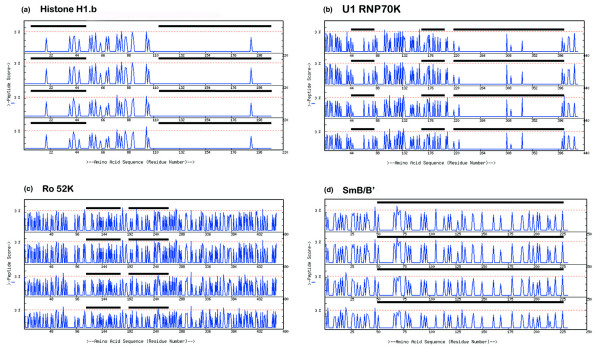
T cell epitopes for several autoantigens predicted by the ProPred server. (a) histone H1b (Swiss-Prot: P10412). (b) U1 RNP70K (Swiss-Prot: P08621). (c) Ro 52K (Swiss-Prot: P19474). (d) Sm B/B' (Swiss-Prot: P14678). Only four alleles are shown for each protein for the HLA antigens (from the top down): DRB1_0101; DRB1_0102; DRB_0301; and DRB1_0305. The patterns for the remaining MHC II alleles follow the same general trends. The black bars highlight the long disordered regions of the sequence as pictured in Fig. 2. The horizontal dotted red line is the threshold score-here set at the default value of 3%, which is used to differentiate between binders and non-binders. A threshold of 3% means that the protein sequence belongs to the 3% best scoring natural peptides. The lower the threshold percentage the fewer false positive peptides will be predicted to be T cell epitopes.